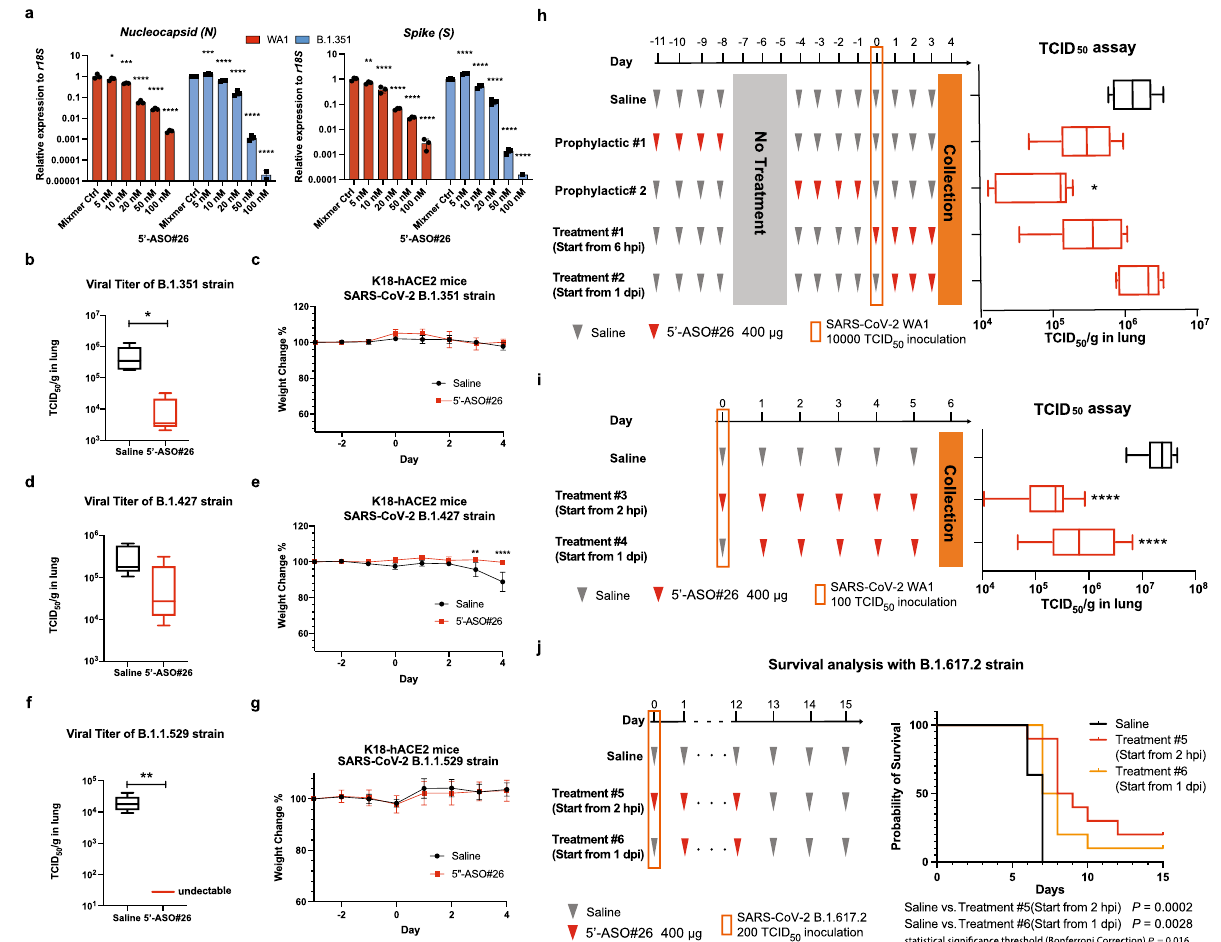
Fig. 5 | Prophylaxis and treatment of SARS-CoV-2 variant strains with 5 ′ - ASO#26. a Dose-dependent effects of 5 ′ -ASO#26 on inhibition of viral replication ofSARS-CoV-2WA1andB.1.351strainswereevaluatedininfectedHuh-7cellsbyRT- qPCR of Nucleocapsid protein (N) and Spike (S) RNA ( N =3, symbols represent mean±SD). One-way ANOVA with Dunnett ’ s test was used to determine sig- ni fi cance. For WA1 (Nucleocapsid), Mixmer Ctrl vs. 5nM, * P =0.0496; Mixmer Ctrl vs. 10nM, *** P =0.0003. For B.1.351 (Nucleocapsid), Mixmer Ctrl vs. 5nM, *** P =0.0001. For WA1(Spike), Mixmer Ctrl vs. 5nM, ** P =0.0033 and groups markedwith****are P <0.0001. b , d and f Theviralburdeninlungsofmicetreated with Saline ( N =5) and 5 ′ -ASO#26 ( N =5) was measured by TCID 50 assay using lung homogenates. Student t -test was used to determine signi fi cance. In b * P =0.0394 c and in f , ** P =0.0060. c , e and g Weight change of mice in b , d and f was mon- itored ( N =5 for control or ASO-treated group in each experiment, symbols represent mean±SD). Two-way ANOVA was used to determine signi fi cance, in e ** P =0.0027, **** P <0.0001. h Mice were administered with different treatment